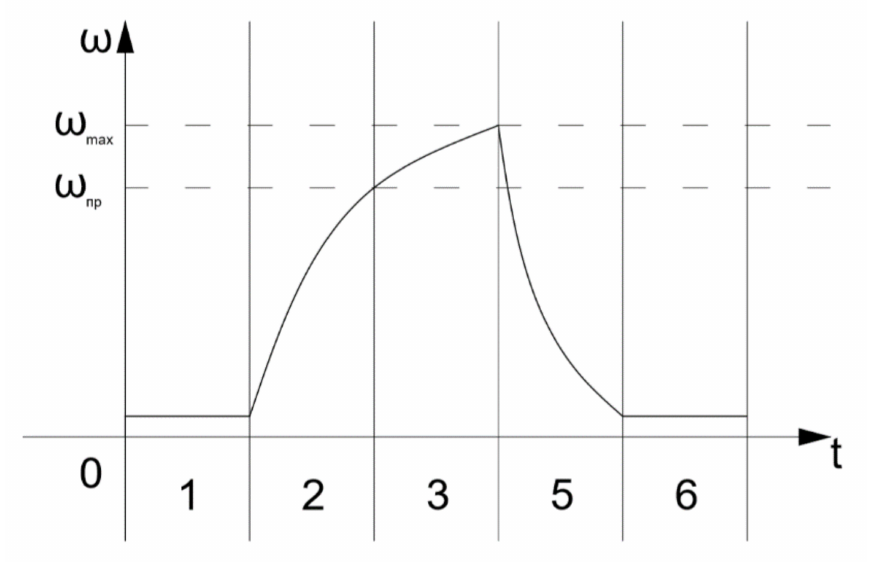
Figure 3. Operation schedule of the drive under short-term wind exposure.